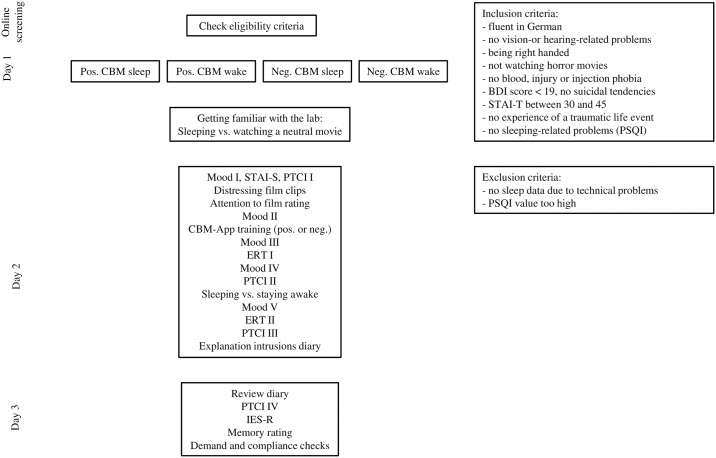
Flowchart procedure.Note: STAI-S: State Trait Anxiety Inventory—State; PTCI: Posttraumatic Cognitions Inventory; ERT: Encoding Recognition Task; IES-R: Impact of Event Scale—Revised.